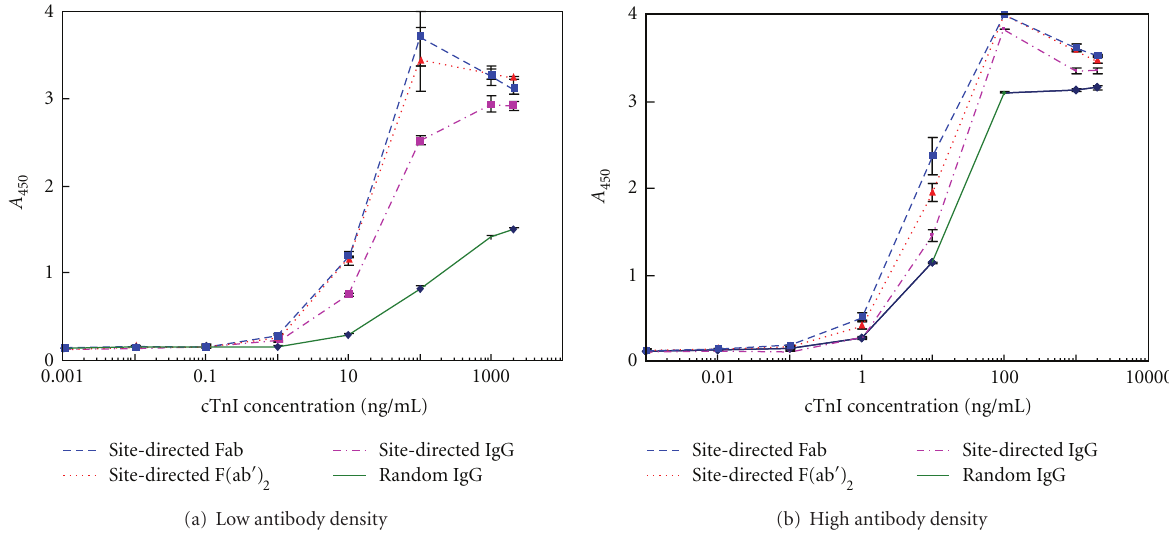
Figure 3: Dose-response curves for binding between each type of biotinylated antibody and cTnI at low (0 . 5 pmol/mL addition) and high (2 . 5pmol/mL) surface densities of the respective antibody. The antibodies were immobilized via biotin-streptavidin linkage and used as the capture for carrying out sandwich enzyme immunoassays for cTnI. The signals produced from the assays were plotted against the analyte concentration. The mean of triplicate determinations for each measurement and the corresponding standard deviations were